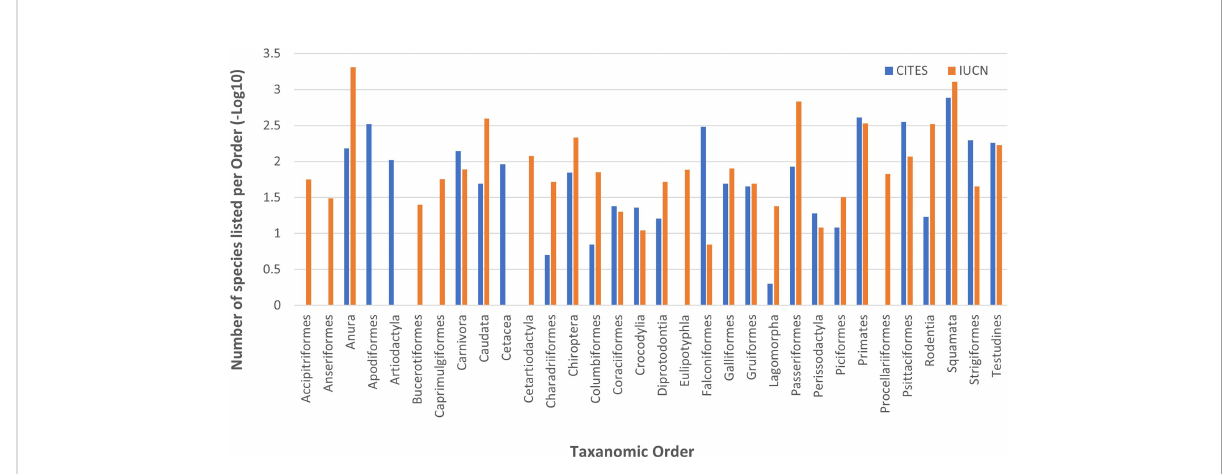
FIGURE 3 Number of species [log transformed] listed per taxonomic order on the IUCN Red List [threatened categories] and the CITES